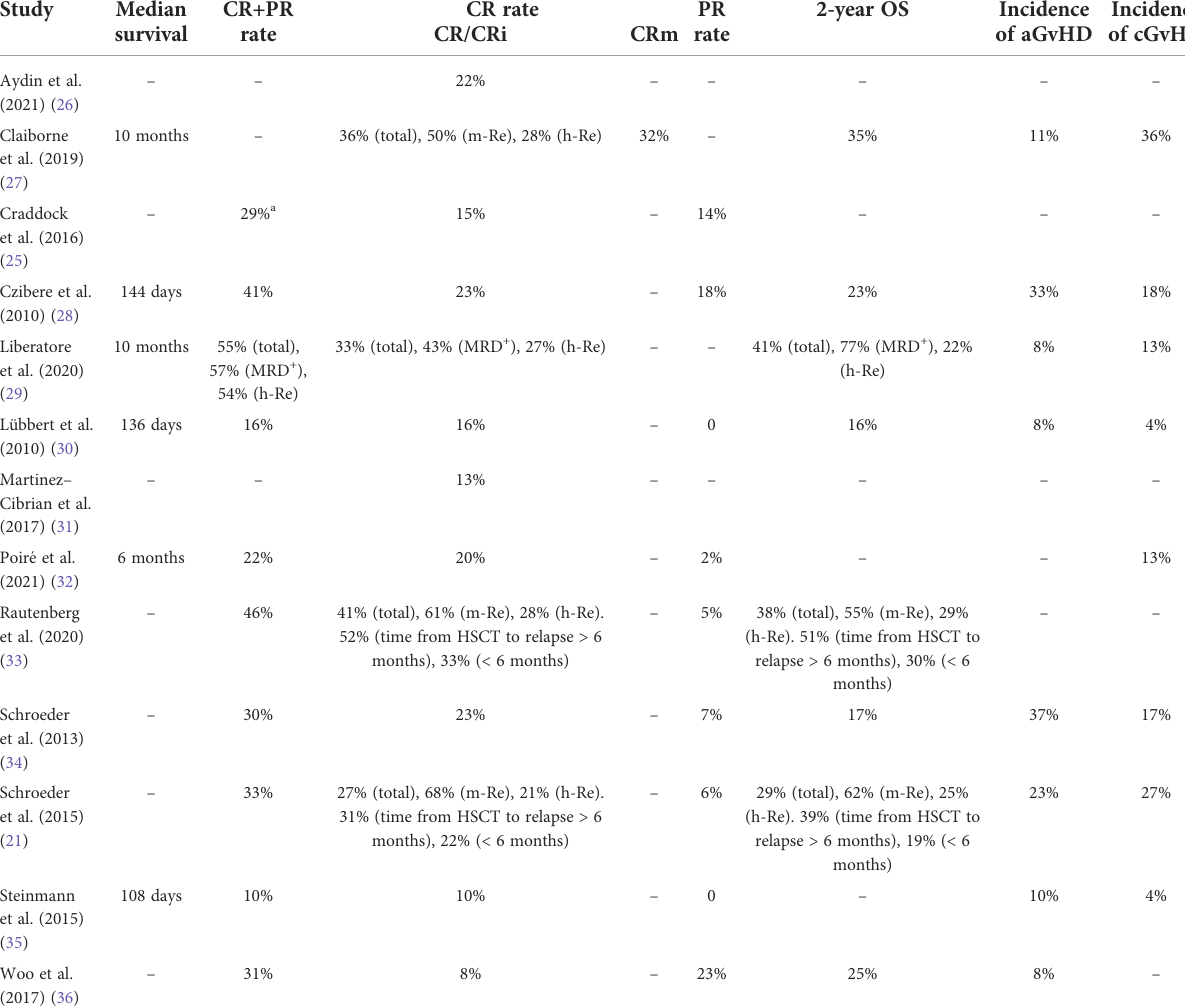
TABLE 3 Outcomes of the azacitidine and donor lymphocyte infusion regimen. Study